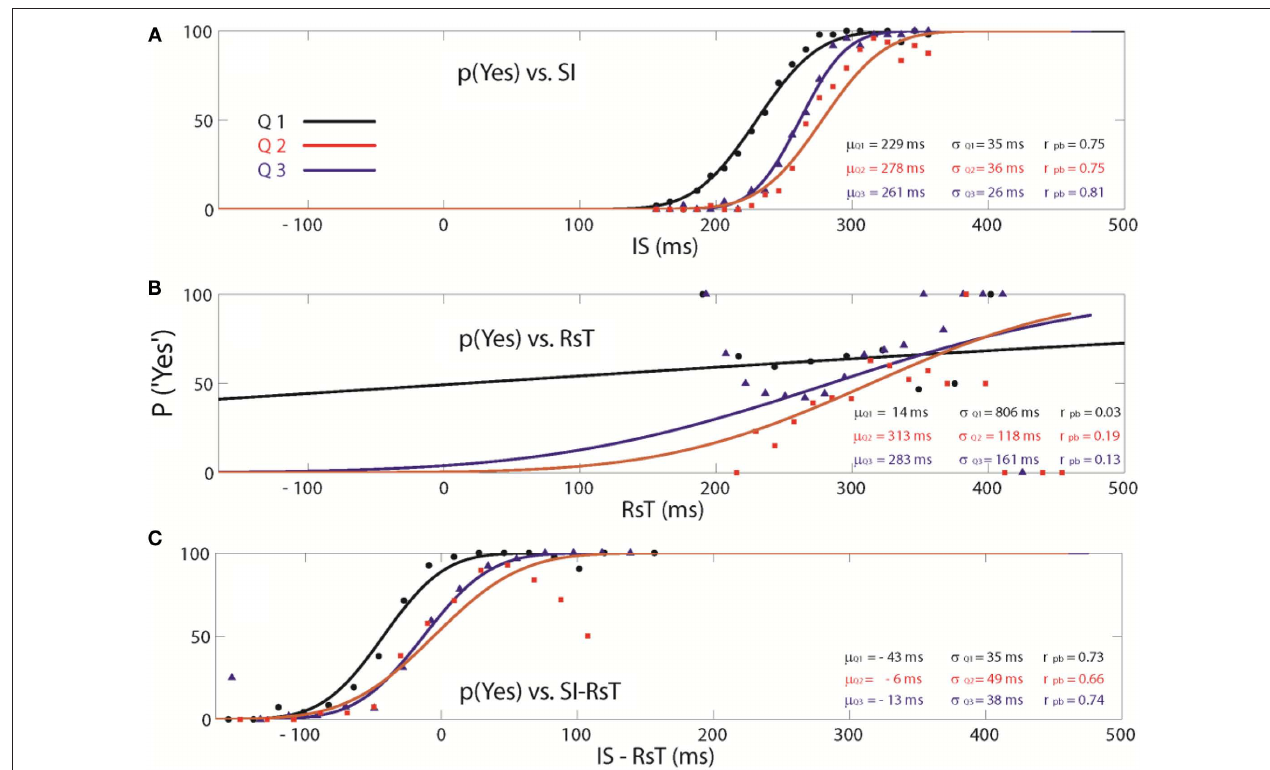
Figure 3 | Percentage of “Yes” responses to Qs1-3 (circles, squares, and triangles, respectively) of a representative subject (SL) as a function of Si (A), rsT (B), and Si-rsT (C) together with the best cumulative gaussian fits (sigmoids of corresponding colors). Insets show the respective means and SDs of the fits.